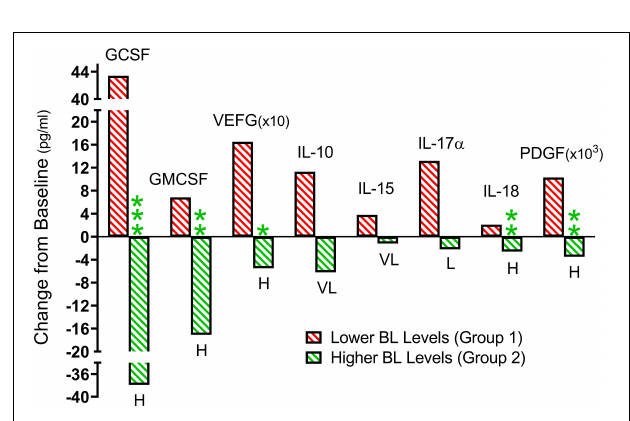
TABLE 4 | Plasma cytokine levels in AD subjects converge to normal or near normal levels following TEMT. FIGURE 5 | From the individual subject results presented in Figure 3 , Cytokine Approximate convergence level Published normal summarized means of TEMT-induced changes for Group 1 (red; lower after 2-months of TEMT (pg/ml) aged level (pg/ml) baseline levels) and Group 2 (green; higher baseline levels). When comparing Group 1 to Group 2, the direction of plasma cytokine response to 2 months of TEMT is universally opposite for all eight cytokines. The difference is frequently significant ( p -value) and there is a substantial Effect Size (clinically important effect) for all eight cytokines. For Group 1 vs. Group 2 significance: * p < 0.05, ** p < 0.02, *** p < 0.001. For Group 1 vs. Group 2 Effect Size: L, large; VL, very large; H,